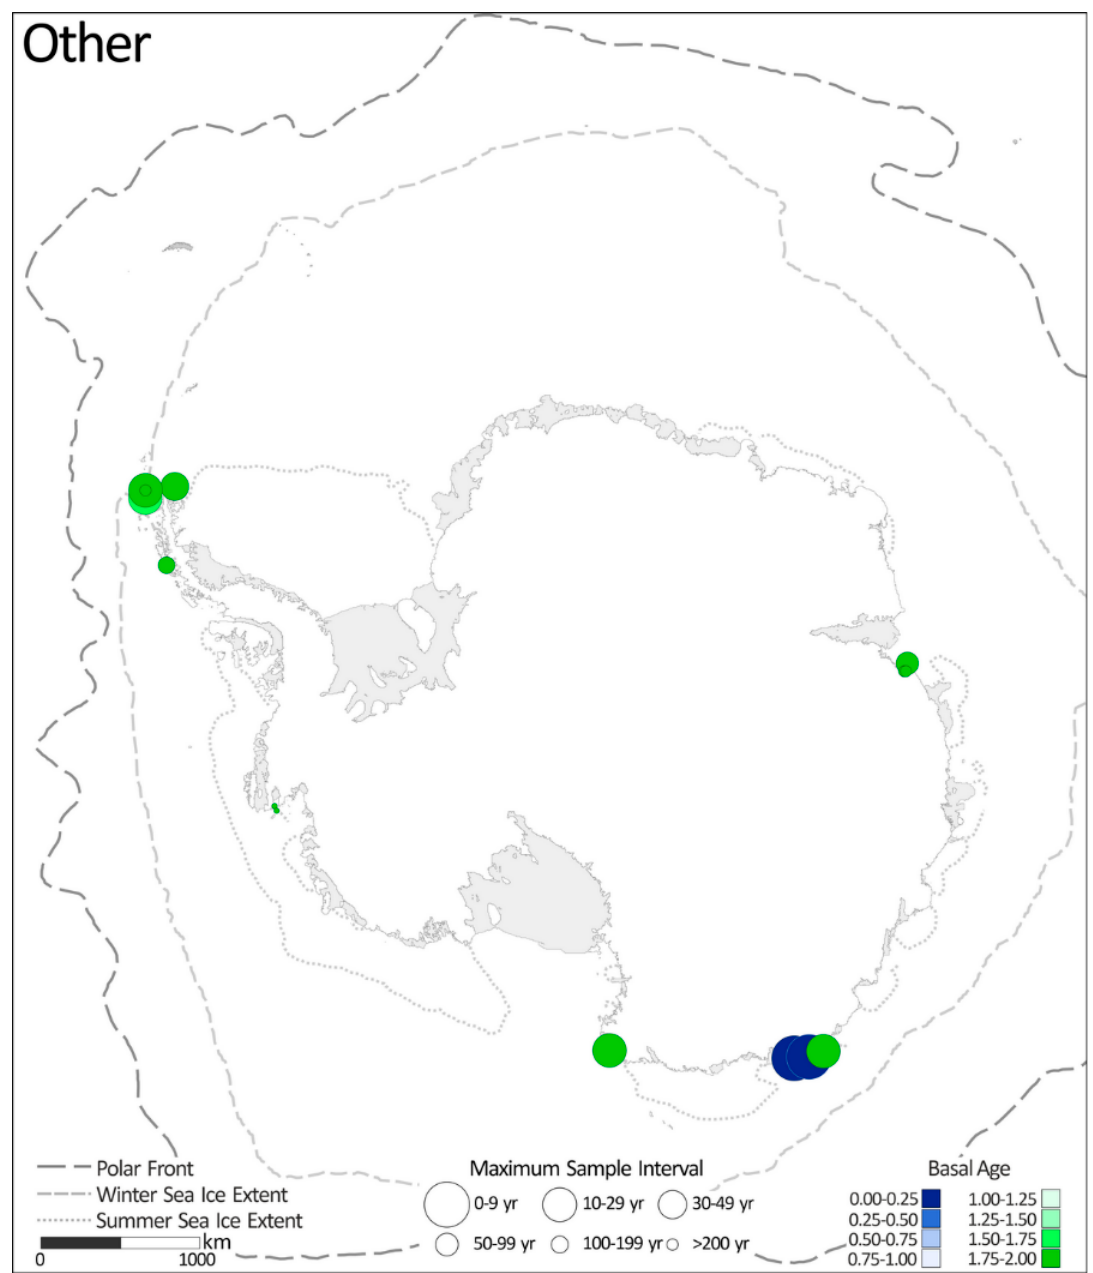
Figure 8. Map showing cores sites where all other proxies based on diatom taxa are used to reconstruct sea ice conditions. The symbol size reflects the resolution of the record and the color of the symbol indicates the basal age of the record between 0 and 2 ka BP.